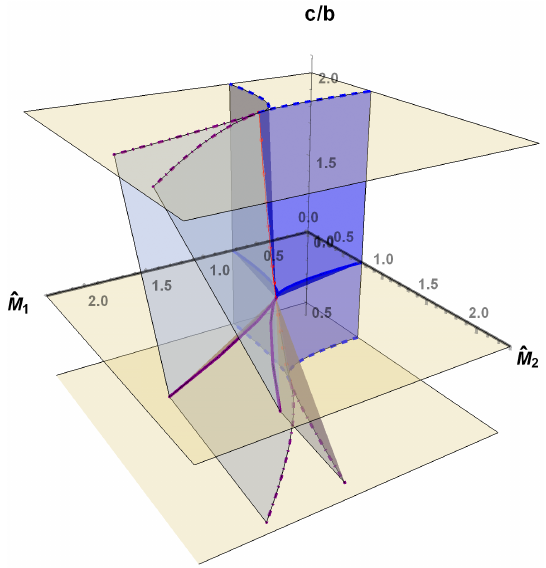
Figure 7. The phase diagram of the system with three dimensionless parameters ˆ M 1 = M 1 /b , ˆ M 2 = M 2 /c and c/b . The red points are critical points forming a line, the blue dashed (blue solid for c/b = 1 ) lines correspond to the critical phases where one pair of the nodes annihilate to a Dirac point while the other pair of nodes still exist (so is the light blue surface) and the purple dotted (purple solid at c/b = 1 ) lines correspond to another critical phase where one pair of nodes vanish and become trivial while the other pair becomes a Dirac node (so is the light purple